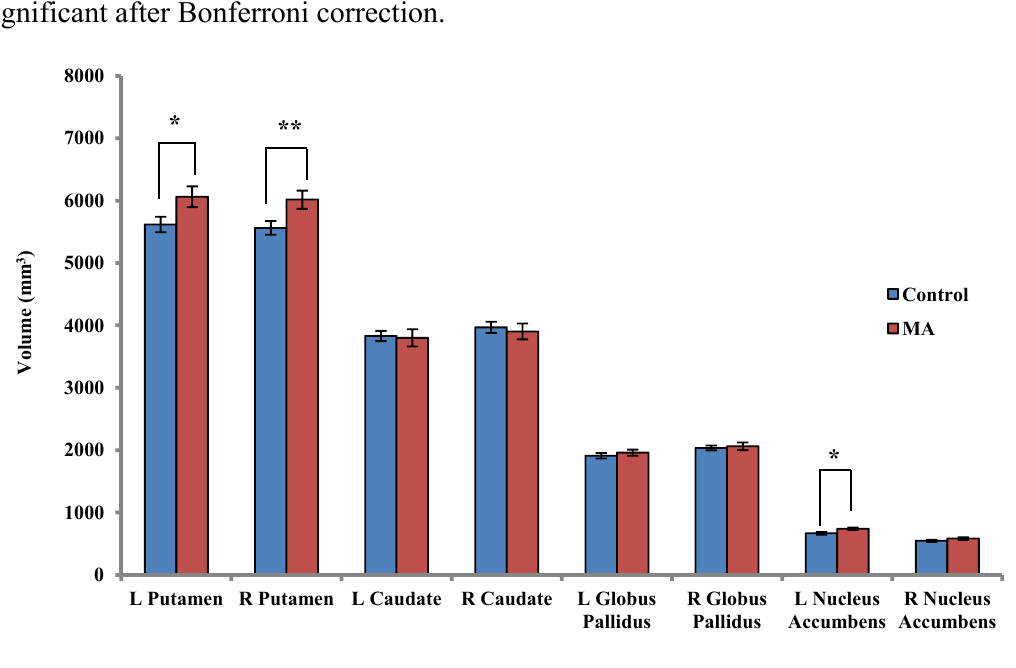
Figure 1. Mean ± standard error subcortical volumes in control participants ( n = 20) and MA-dependent participants ( n = 17), * p < 0.05 before Bonferroni correction, ** significant after Bonferroni correction.